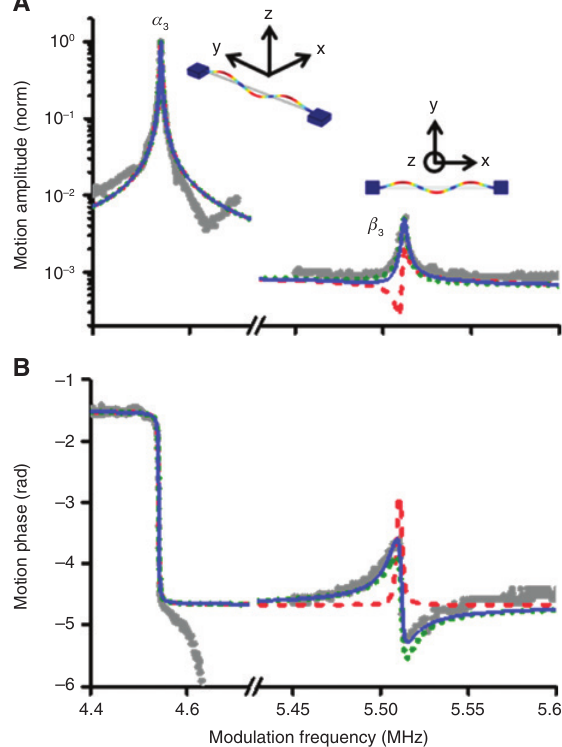
Figure 4: Mechanical response for third-order flexural modes. Cartoons are FEM simulations of the mode shapes. (A and B) Amplitude and phase of forced mechanical oscillations. Gray dots: experimental data. Scans on the two modes were taken separately, setting the phase of the lock-in to zero before each scan. The measurement was taken under an incident modulated THz power of 1.75 mW. Red dashed lines: amplitude and phase calculated from the = 0, corresponding to two thermally driven model of Eq. (1) with A C modes. Green dotted lines: amplitudes and phase calculated from = 0, corresponding to a thermally driven the model of Eq. (1) with A T α mode and a Coulomb-driven β mode. Blue solid lines: amplitudes 3 3 and phase calculated from the model of Eq. (1), corresponding to a thermally driven α mode and a β mode which is 94% Coulomb 3 3